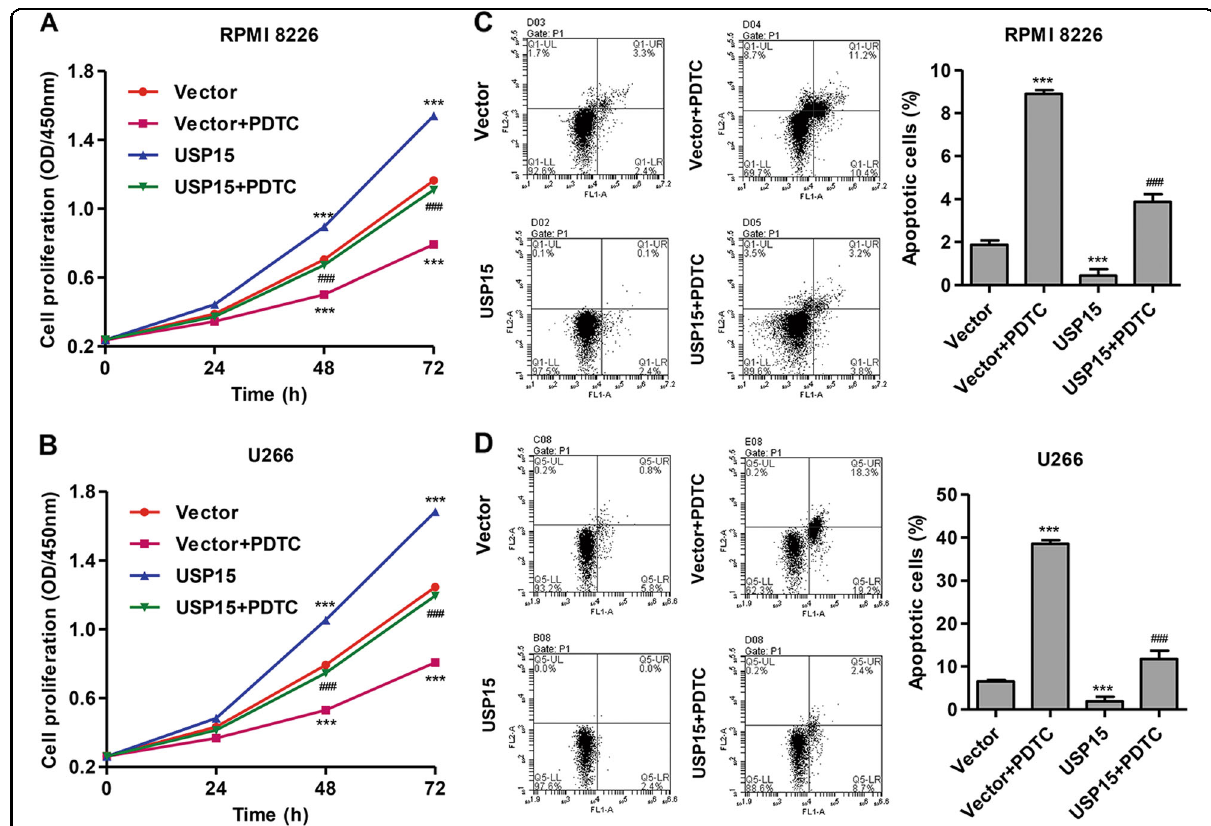
Fig. 6 PDTC treatment inhibits USP15 overexpression-induced cell proliferation and apoptosis inhibition in MM. After RPMI 8226 and U266 cells cultured in complete medium containing either PDTC (50 μ M) or no inhibitors were transfected with pLVX-Puro-USP15, proliferation was measured with the CCK-8 assay ( a , b ) and apoptosis was measured by fl ow cytometry with Annexin V-FITC/PI staining ( c , d ). *** P < 0.001 compared with vector. ### P < 0.001 compared with